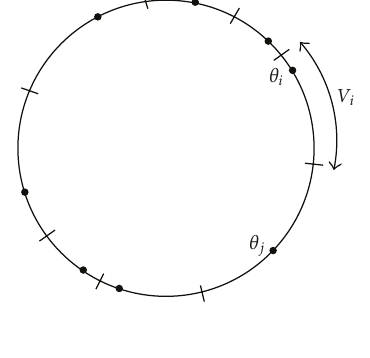
Figure 4: Voronoi partition of S 1 generated by θ 1 , ... , θ N .